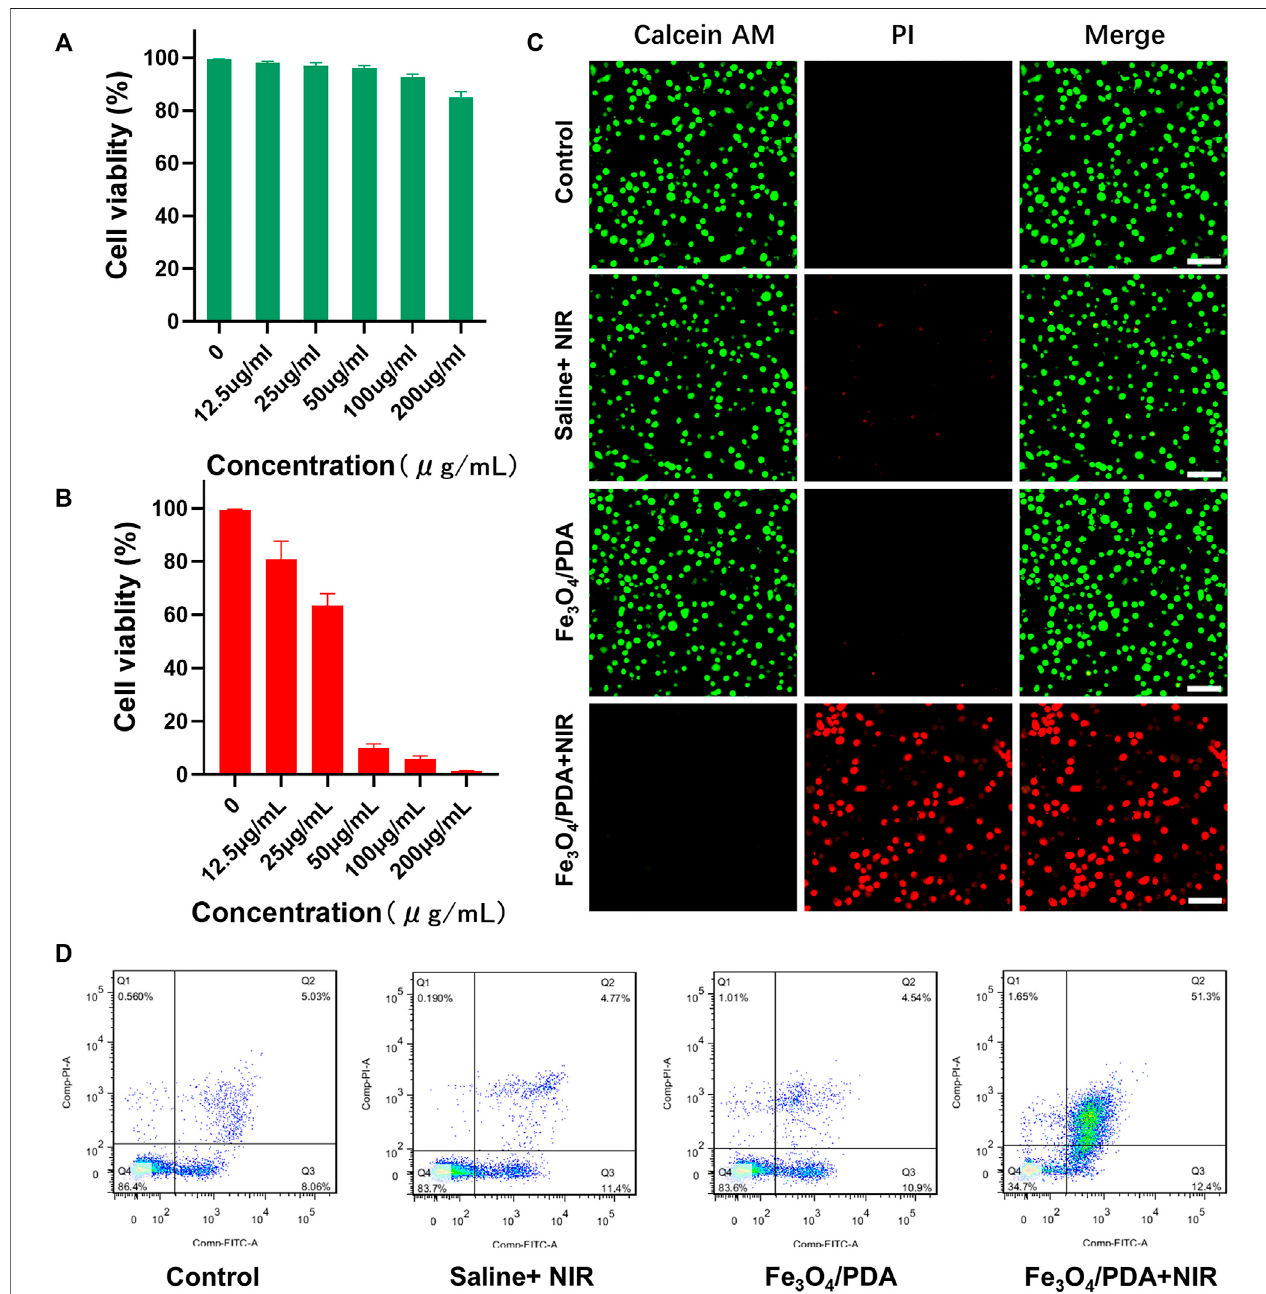
FIGURE 4 | (A) The viability of cells treated with a range of Fe 3 O 4 @PDA concentrations for 24 h. (B) The viability of 143B cells following PTT, with irradiation being performed using an 808 nm laser in appropriate groups. (C) Fluorescent images of 143B cells in the indicated treatment groups that had undergone live/dead staining (Scale bar = 100 μ m) (D) Representative fl ow cytometry plots for cells in the indicated treatment groups.